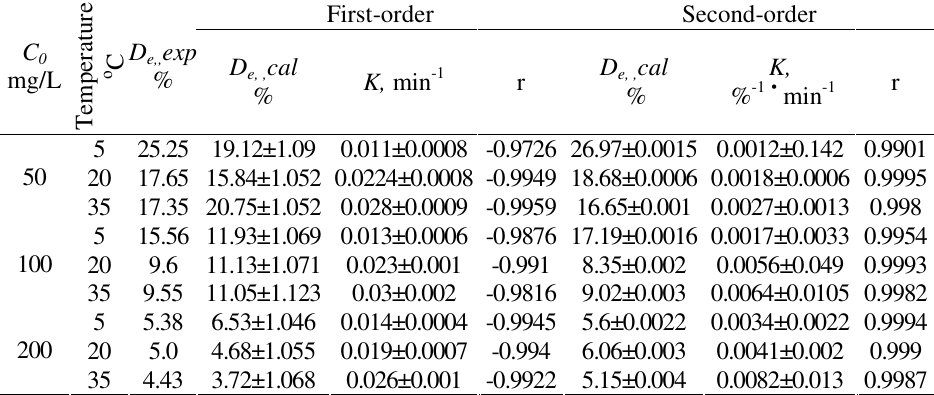
Table 3 . Comparison of decolorization kinetic models